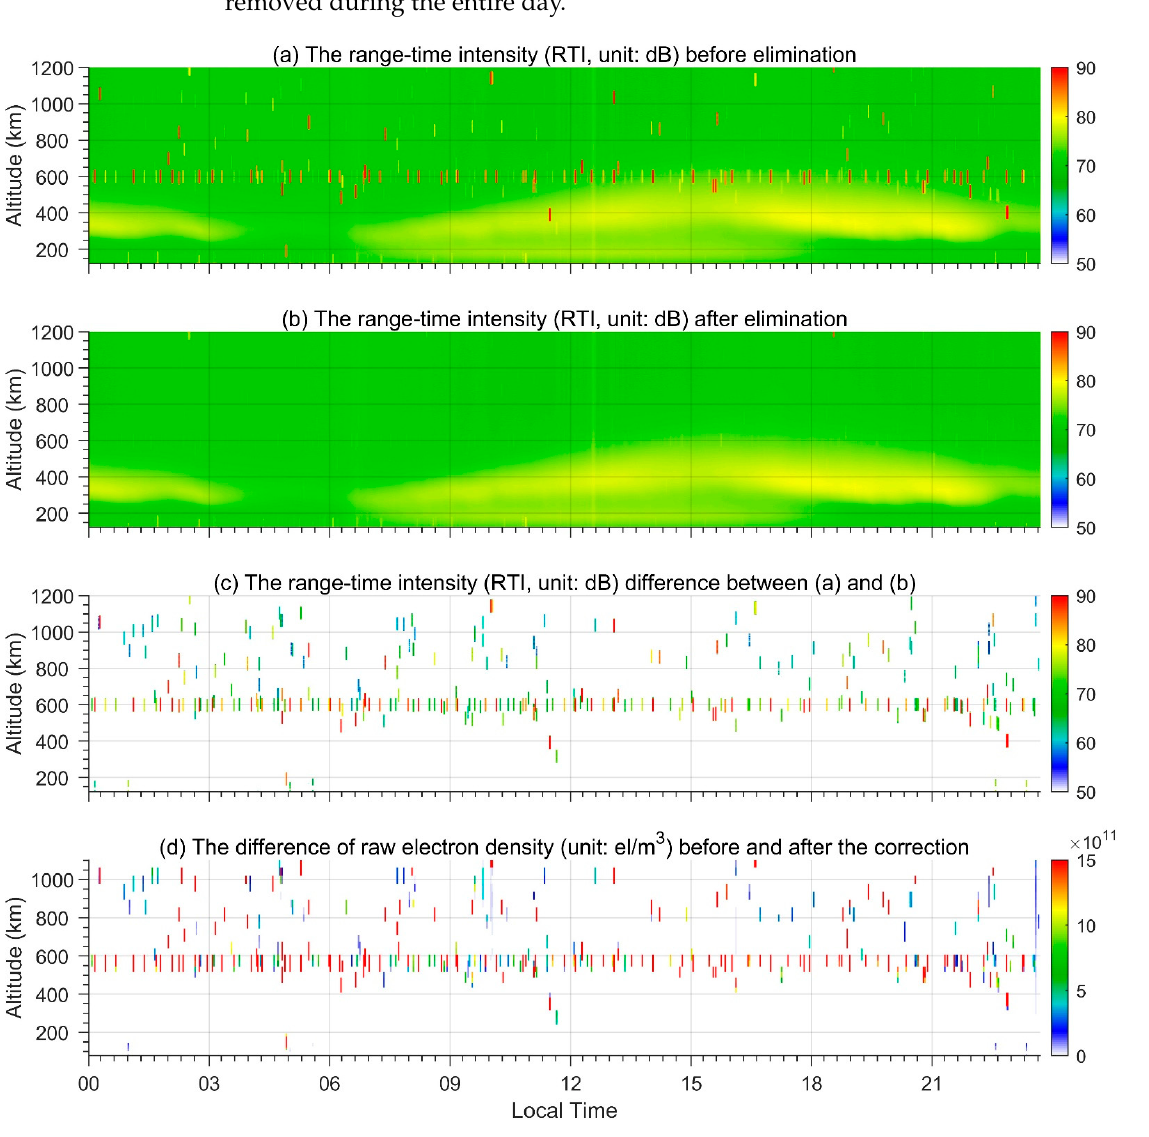
Figure 3. Range-time-intensity (RTI, unit: dB) of the ionosphere observations during 14 April 2022 using the alternating code (AC) signal before ( a ) and after ( b ) eliminating the space object pollution using the SO-CFAR algorithm. Panel ( c ) is the difference between ( a ) and ( b ), which indicates the identified space object occurrences. Panel ( d ) is the error of the raw electron density before and after the removal of space